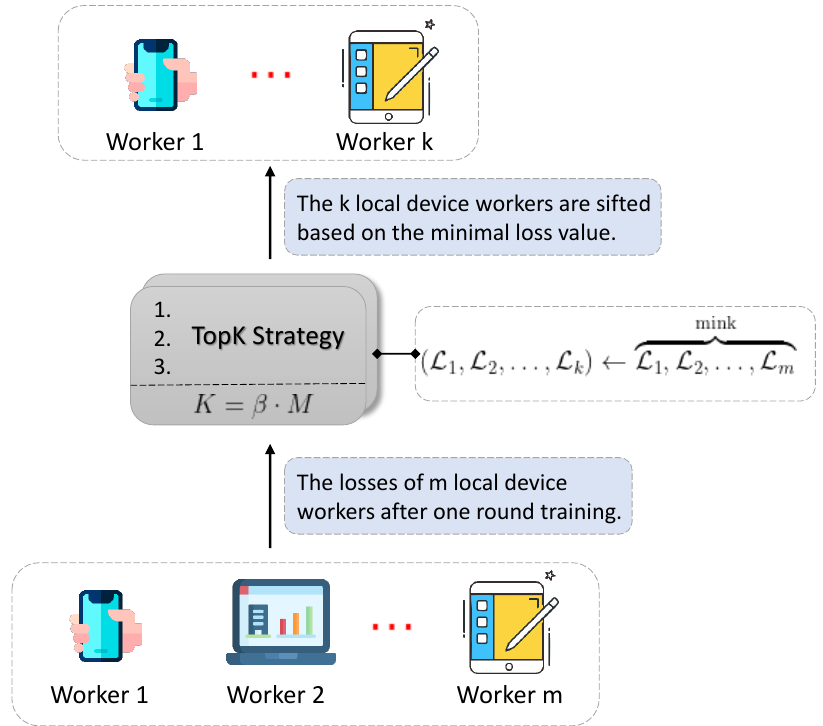
Figure 3. The illustration of how TopK rankings strategy